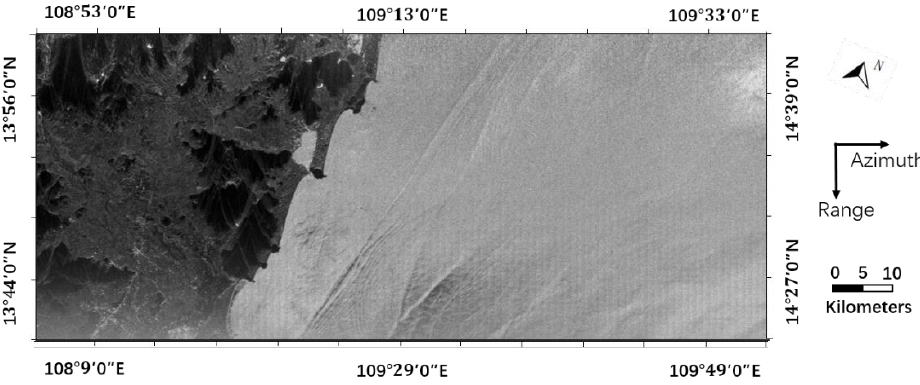
Figure 6. SAR intensity image of the South China Sea, acquired by InIRA in September 2016. The image is geocoded, the modulation of antenna pattern along the range direction is corrected. The azimuth and range directions are indicated by arrows.